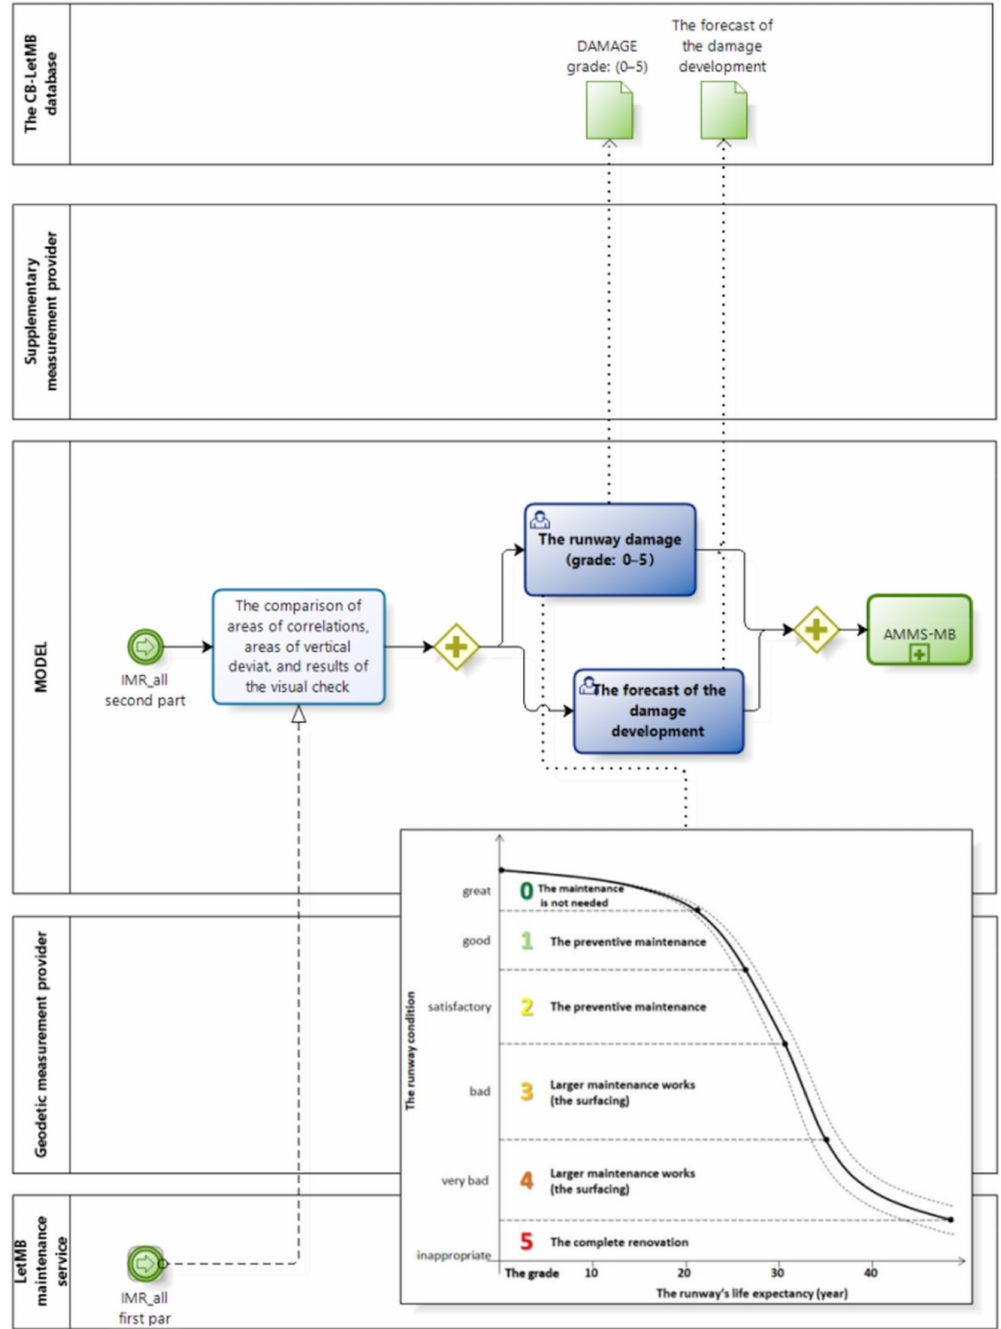
Figure 10. Third part of BPD’s process decision-making maintenance model IMR_all, with the level of runway condition (the level of